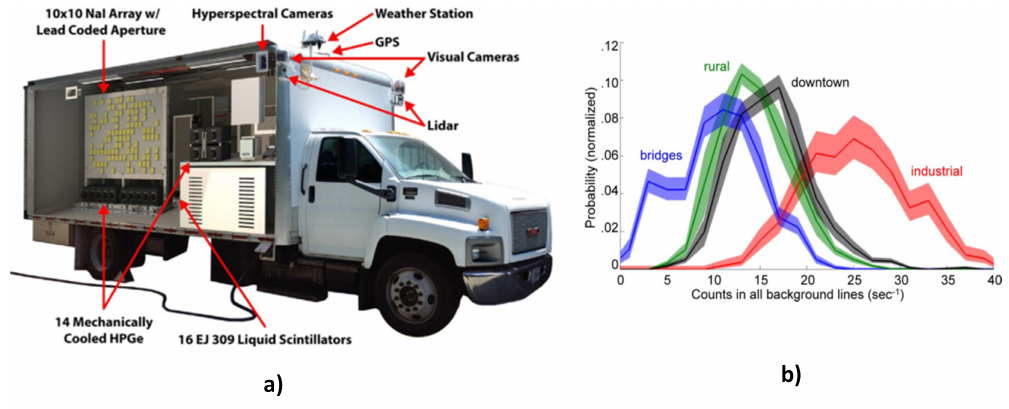
Figure 7. ( a ) Radiological Multi-sensor Analysis Platform (RadMap) [40]; ( b ) background radiation distribution classified by location